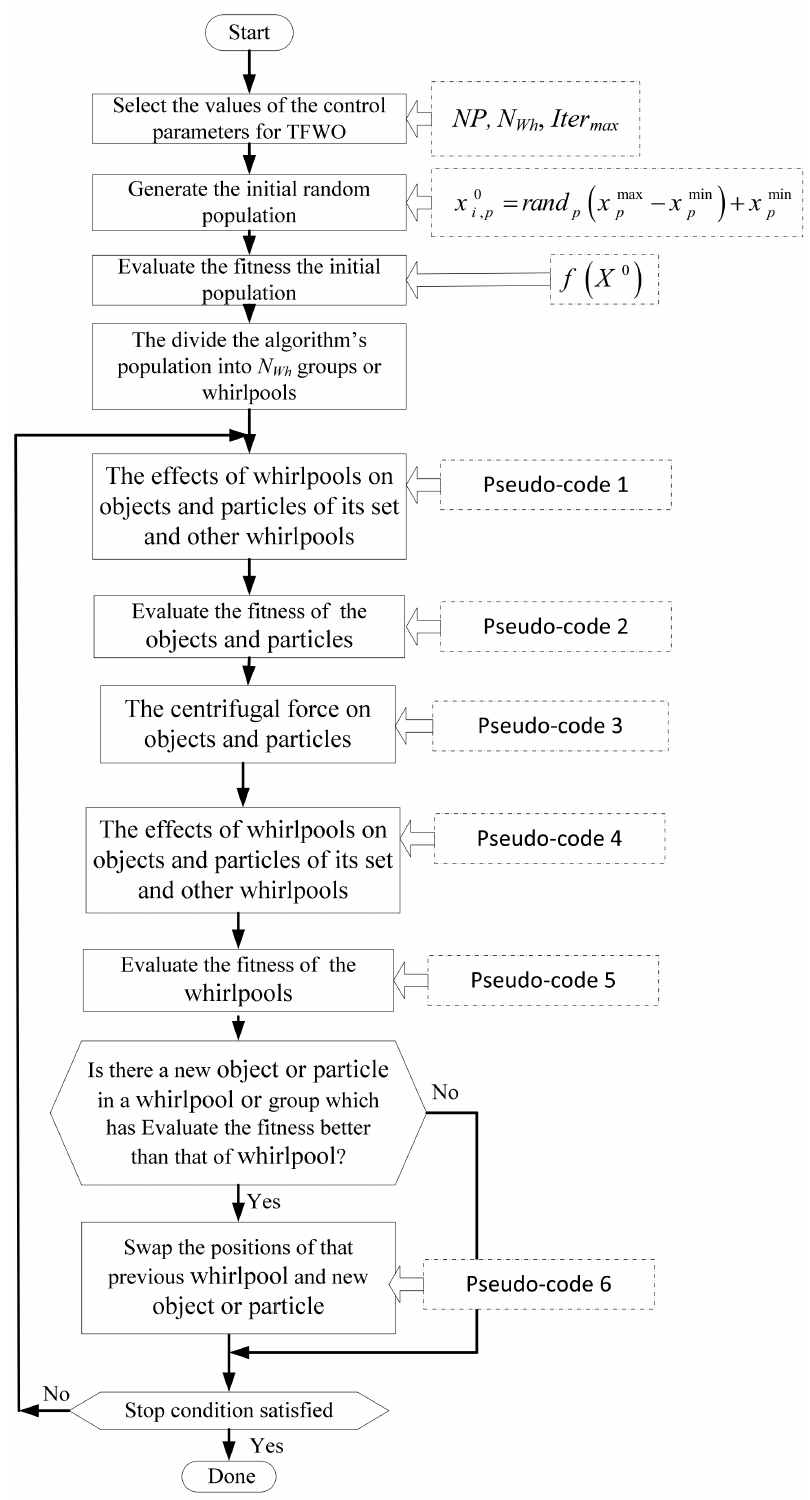
Figure 3. Flowchart of the original